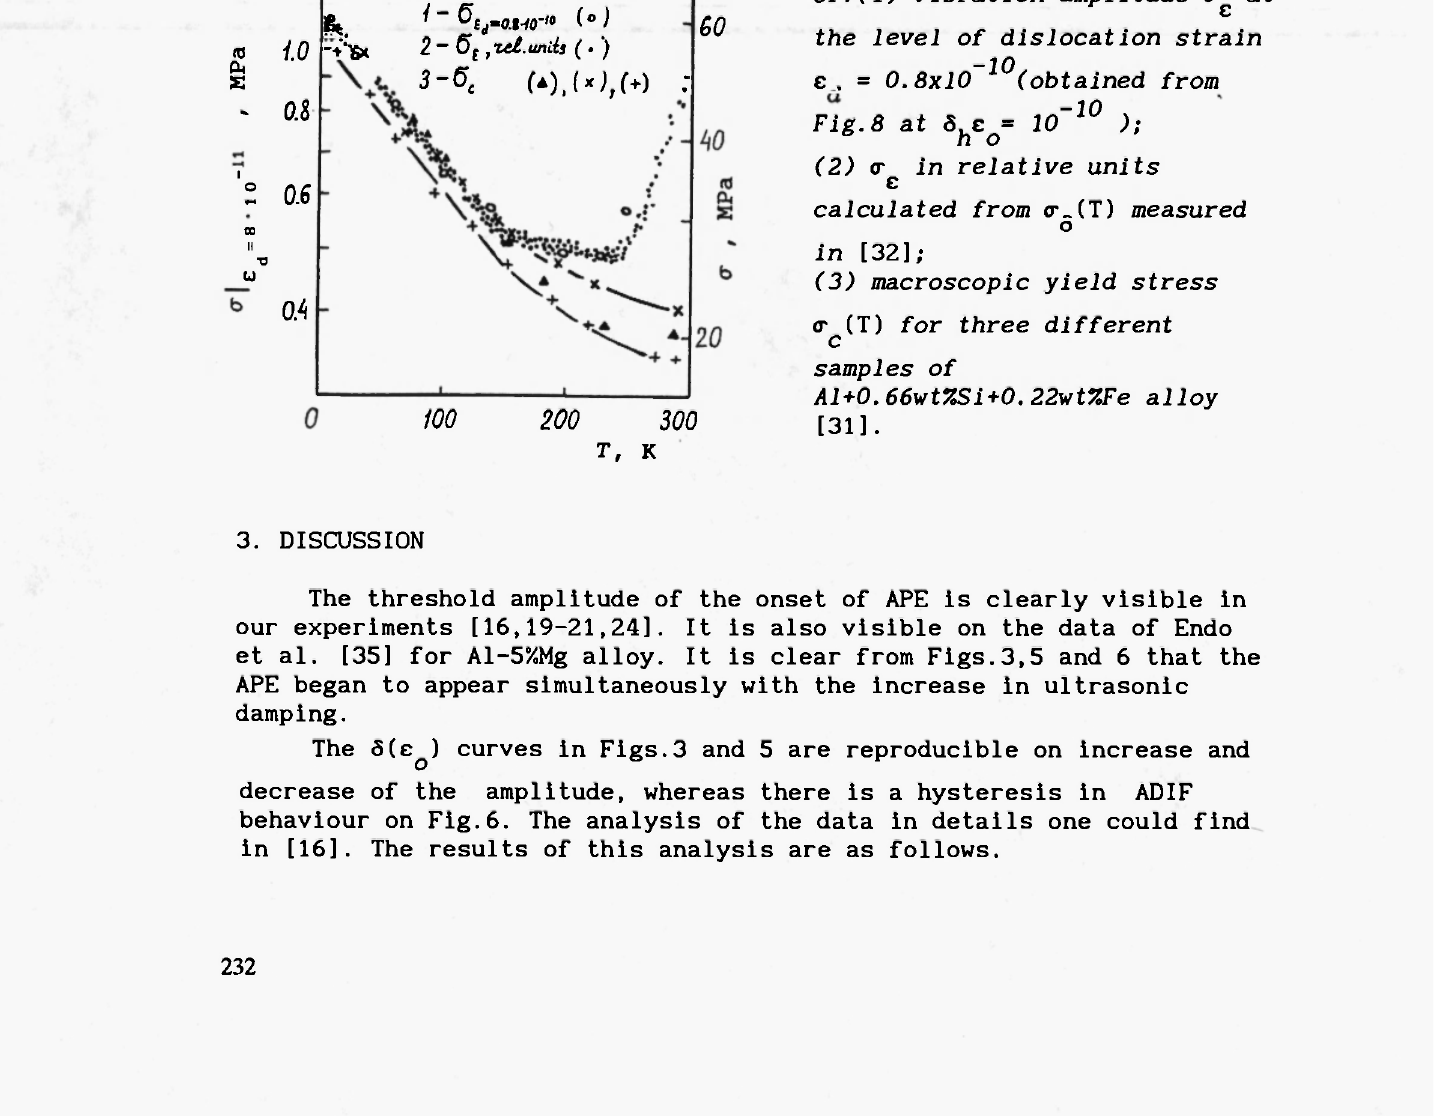
FIG.10. Temperature dependences of:(l) vibration amplitude σ^ at the level of dislocation strain ε , = 0.8xl0~ 10 (obtained from -10 Fig.8 at δ, ε = 10 χ ); ho (2) σ in relative units ε calculated from σ_(Τ) measured ο in [32]; (3) macroscopic yield stress <r CT) for three different c samples of Al+O.66wt%Si+0.22wt%Fe alloy